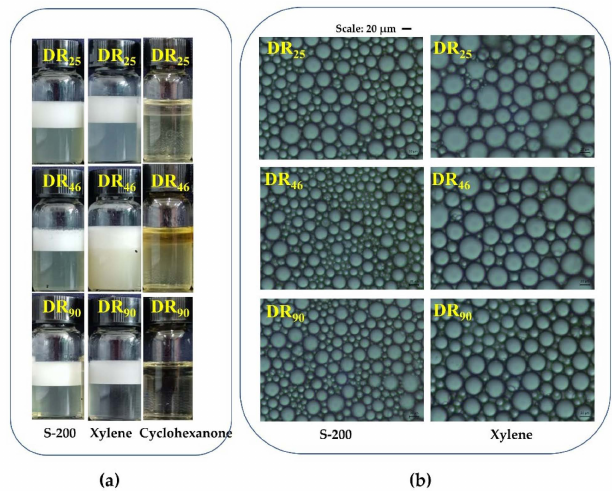
Figure 3. Emulsifying activity of DR 25 , DR 46 and DR 90 toward S-200, xylene and cyclohexanone. ( a ) Emulsification layer formed in solvents; ( b ) The morphology of emulsified